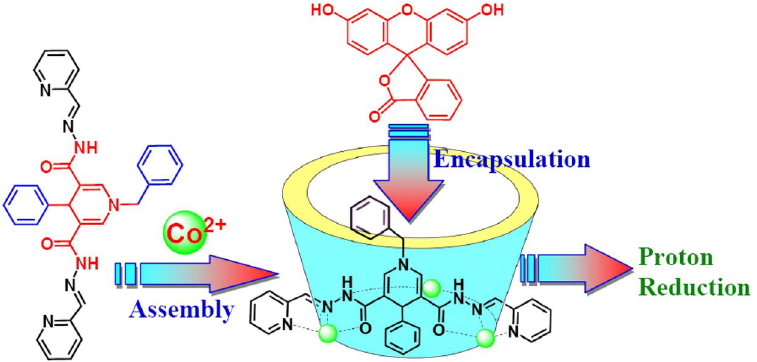
Figure 1. Perspective view of the supramolecular structure of the AP system for light-driven H 2 production, showing the construction of the nanocage host as a proton reductive catalyst and the encapsulation of Fl guest as a photocatalyst.